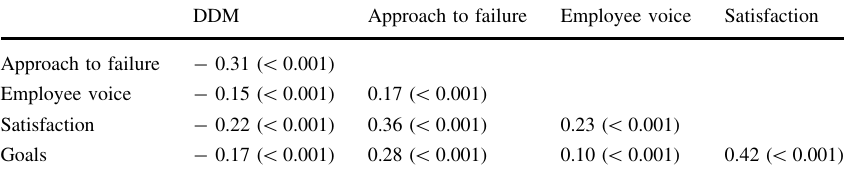
Table 2 Correlation between constructs